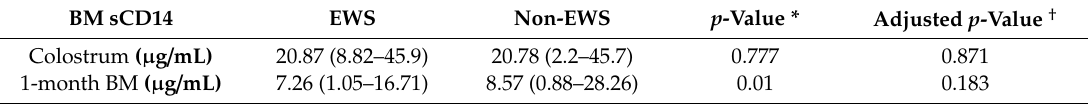
Table 4. Association of BM sCD14 with sensitization to egg white (EWS) at 9 months of age. BM sCD14 EWS Non-EWS p -Value